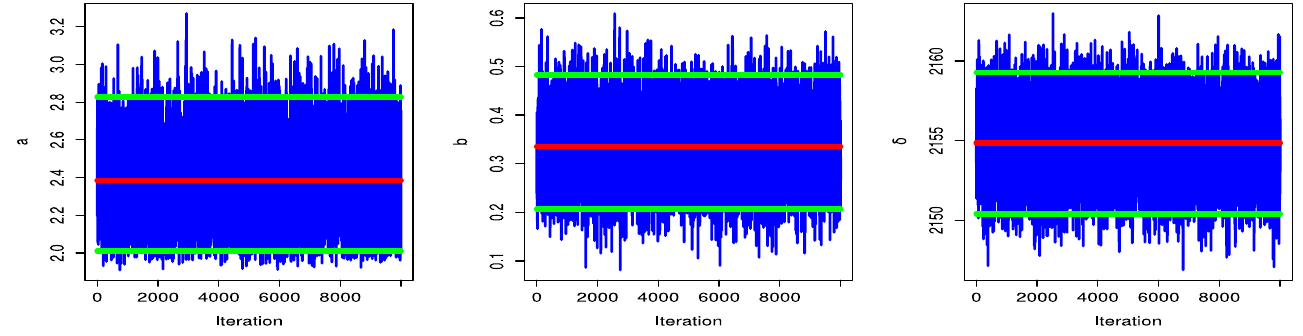
Figure 13. Trace plots of MCMC results with interval limit line for the United Kingdom data set. The autocorrelation function (ACF) is generated as shown in Figures 14 and 15.